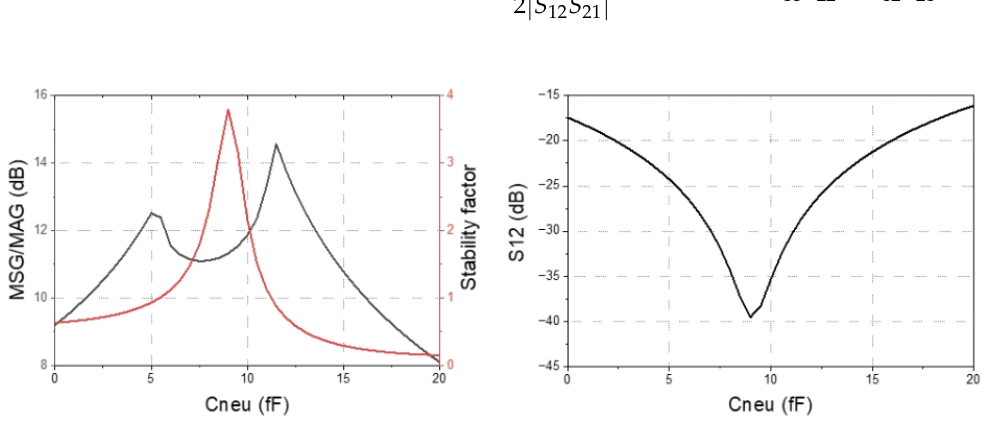
Figure 5. MSG/MAG, stability factor, and reverse isolation according to C neu at 70 GHz.